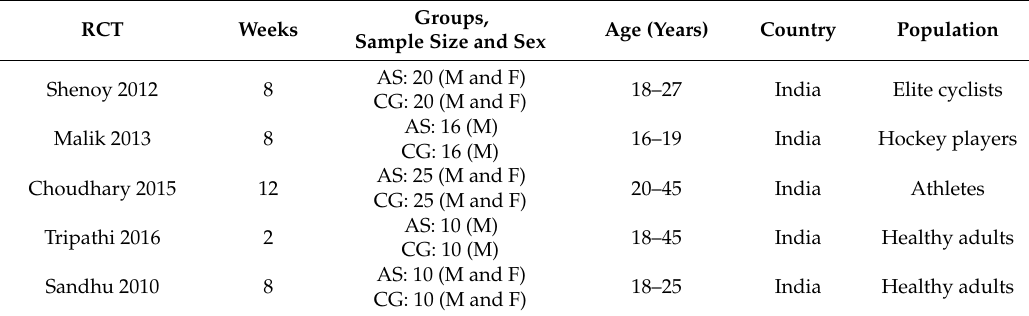
Table 1. Characteristics of the sample.